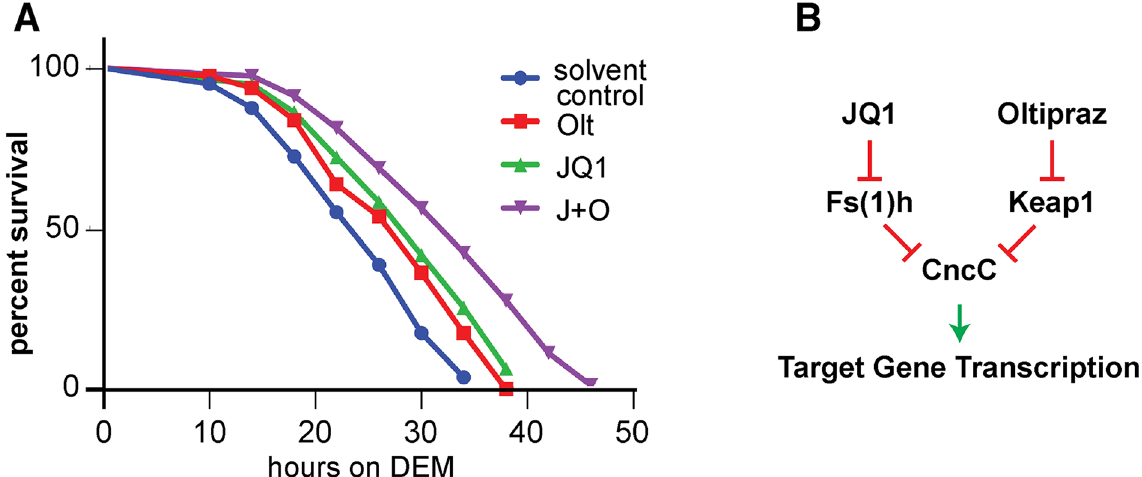
Fig 6. Simultaneous inhibition of Keap1 and BET proteins impart enhanced oxidative stress tolerance. (A) 5 day old female w 1118 flies were placed on food containing 0.4mM oltipraz and/or 0.1mM JQ1 for 4 days and then were exposed to 20 μ M DEM. Survivorship was assessed. Mantel-Cox log-rank test showed that pre-treatment with either oltipraz or JQ1 significantly increased oxidative stress tolerance (P value < 0.005 for control/oltipraz comparison and P value < 0.001 for control/JQ1 comparison). It was also found that pre-treatment with both oltipraz and JQ1 extended survival after DEM exposure significantly more than pre- treatment with either drug alone (P value < 0.001 for olt/combined comparison and P value < 0.005 for JQ1/combined comparison). Qualitatively identical results were found when males were used (S3D Fig). (B) Proposed model for synergistic activation of Nrf2 signaling by oltipraz and JQ1. CncC is regulated independently by Keap1 and Fs(1)h. Treatment of cells with the Keap1 inhibitor oltipraz relieves a different mechanism of CncC inhibition from that relieved by the BET protein inhibitor JQ1. Combining both manipulations, therefore, has a stronger effect than either treatment by itself and causes a cooperative activation of CncC target